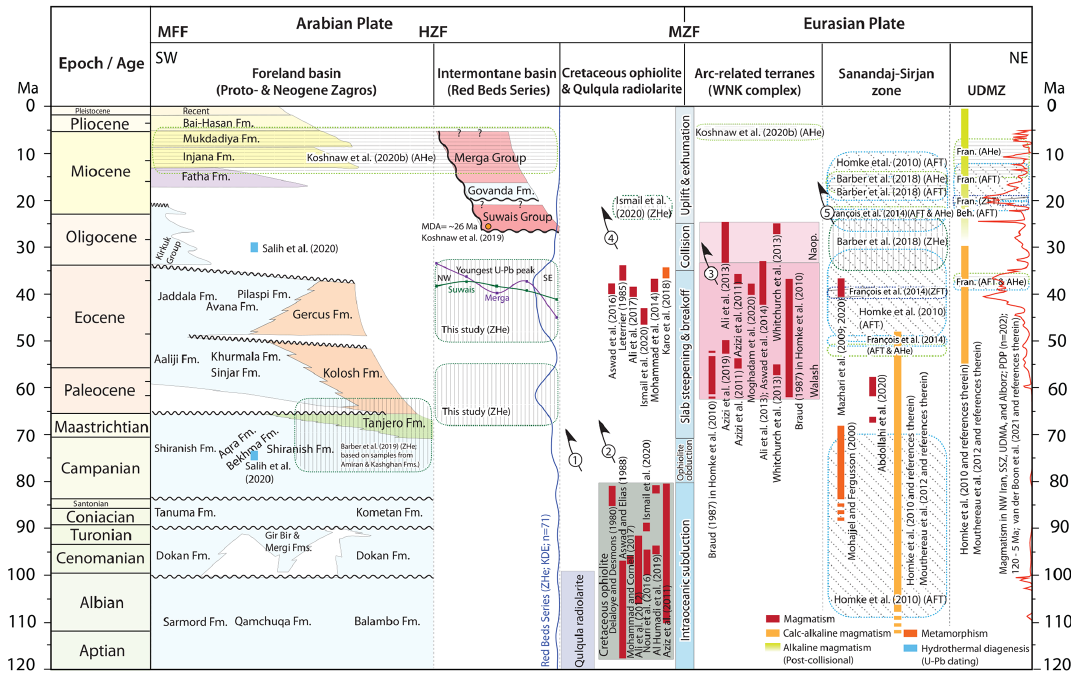
Figure 12. Time–space chart synthesizing hinterland basin stratigraphy and structural zone thermochronological and geochronological con- straints on key tectonic and geodynamic, metamorphic, magmatic, and exhumational events in the broader NW Zagros sector. Numbered arrows represent the estimated relative timing of the thrusting of their respective terranes. Foreland basin stratigraphy is based largely on van Bellen et al. (1959), Aqrawi et al. (2010), and Al-Husseini (2000). The abbreviations used in the figure are as follows: MDA, maximum depositional age; AHe, apatite (U–Th) / He; ZHe, zircon (U–Th) / He; AFT, apatite fission track; ZFT, zircon fission track; MFF, mountain front flexure; HZF, High Zagros fault; MZF, Main Zagros fault; WNK, Walash–Naopurdan–Kamyaran; UDMZ, Urumieh-Dokhtar magmatic